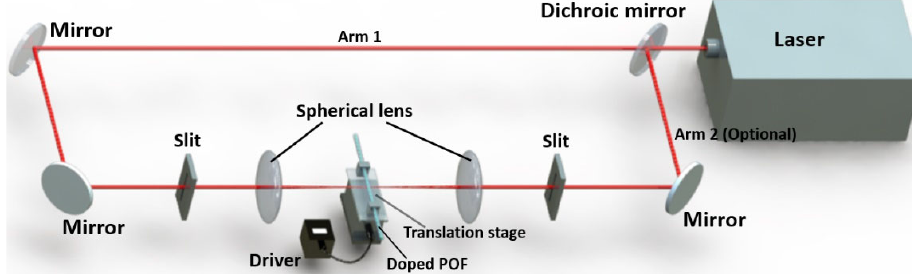
21 of 26 Figure 19. ( a ) Experimental set ‐ up of LPFG inscription in an MVK ‐ doped POF with an HPML; ( b ) The transmitted amplitude spectrum of the LPFG. Reprinted with permission from [16]. In 2013, Wang et al., inscribed a LPFG with ~13 dB transmission loss in a 9 ‐ VA ‐ doped PMMA POF under very low intensity (3.1 mW/cm 2 ) for 10 min (2 min per point) exposure of UV lamp (365 nm dominant) [30]. The schematic of PbP inscription set ‐ up is similar to Figure 20, but only one arm was employed in this work. Later, in 2014, Kowal et al., used the same technique to inscribe a ~20 dB LPFG in a TS ‐ doped cladding PMMA POF, prov ‐